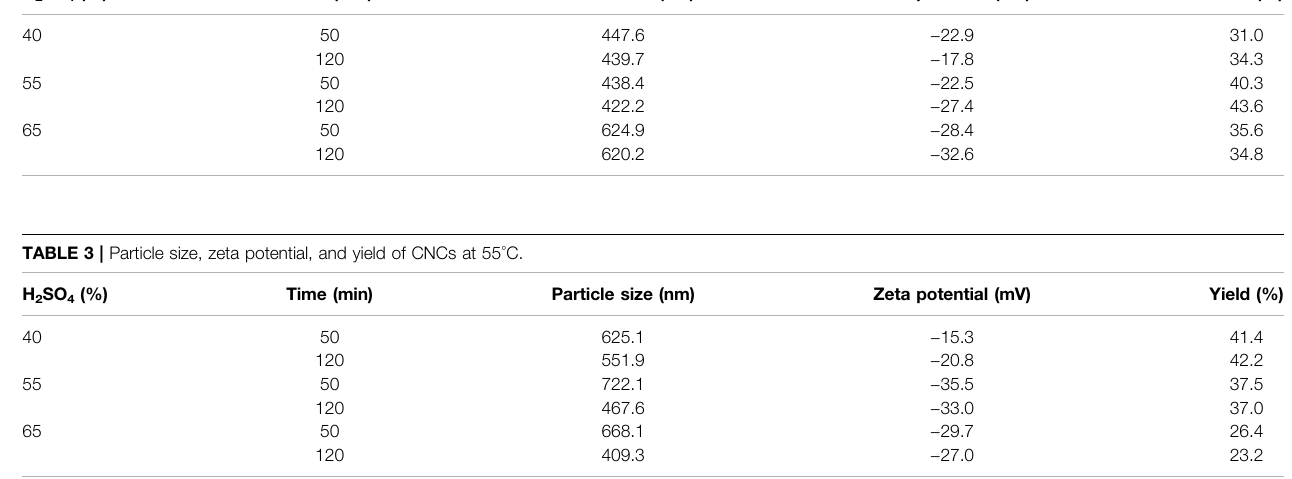
TABLE 2 | Particle size, zeta potential, and yield of CNCs at 40 ° C. H 2 SO 4 (%)